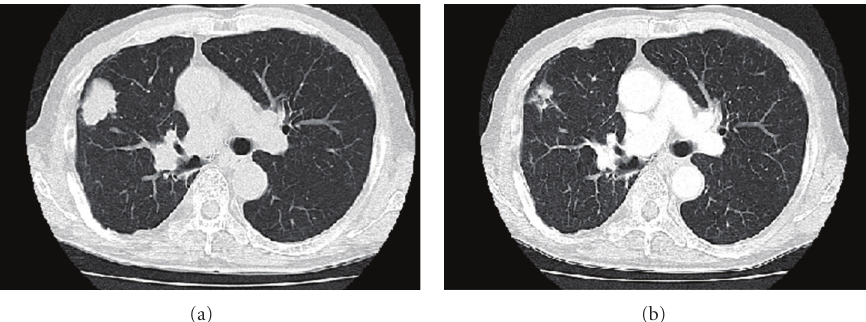
Figure 2: Chest CT of case 2 demonstrating tumor of the right upper lung (a). CT after the first cycle of the chemotherapy demonstrated remarkable response